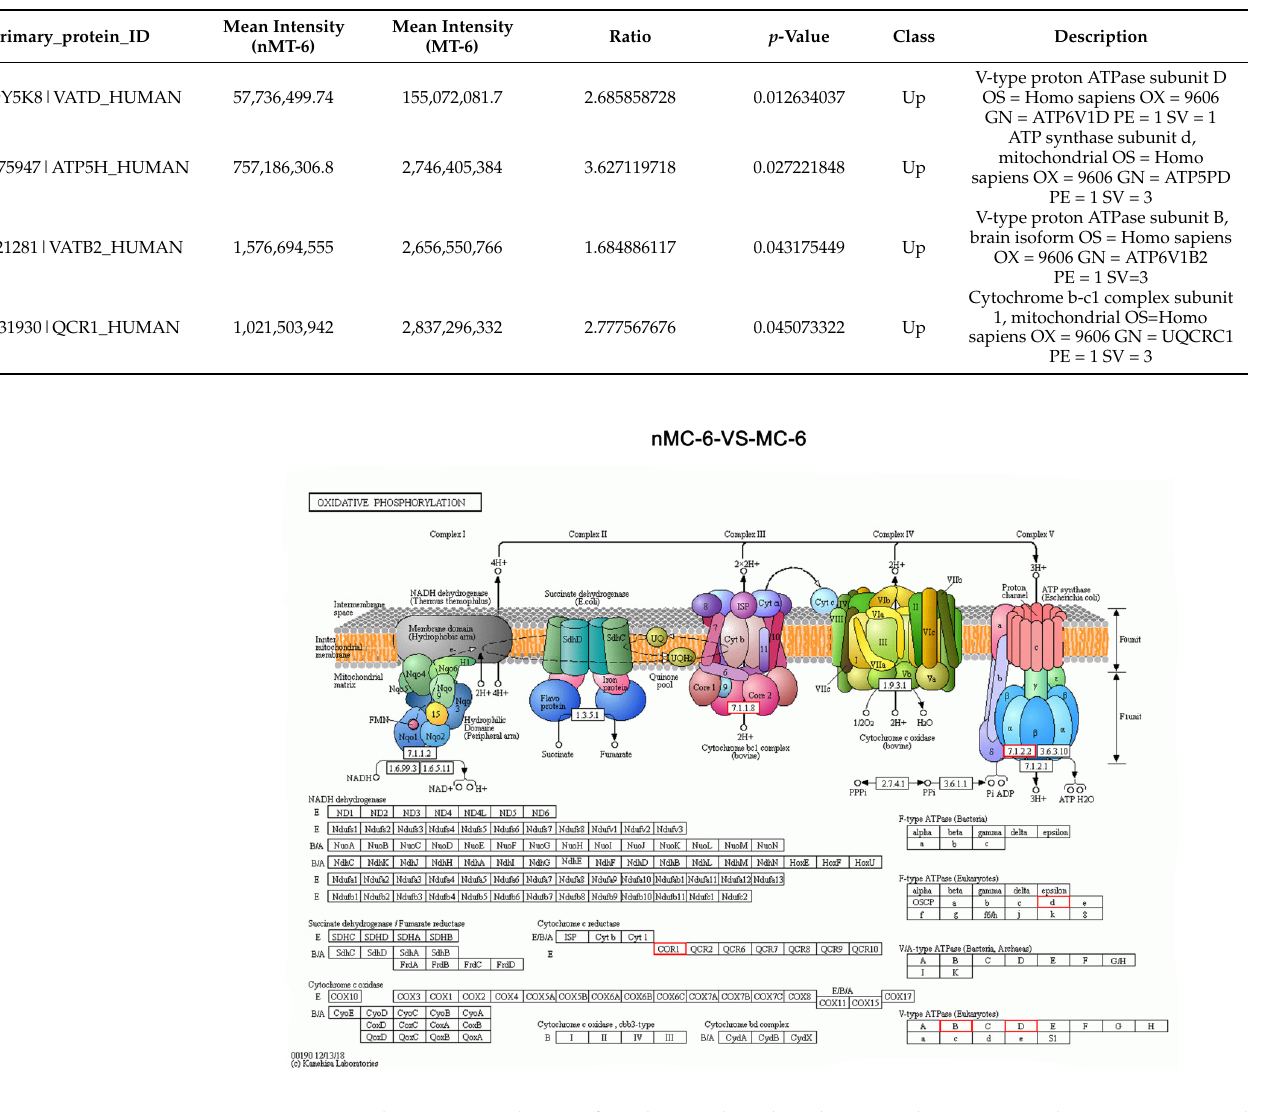
Figure 5. The KEGG pathway of oxidative phosphorylation pathway responds to cryopreserved human oocytes. The proteins highlighted in red are enriched and significantly upregulated in oocytes from the latter group. nMC-6 VS MC-6: Comparison of DEPs in oxidative phosphorylation pathway between nMC-6 group and MC-6 group. Table 3. Statistical table of the number of differential proteins related to oxidative phosphorylation pathway between nMC-6 group and MC-6 group.